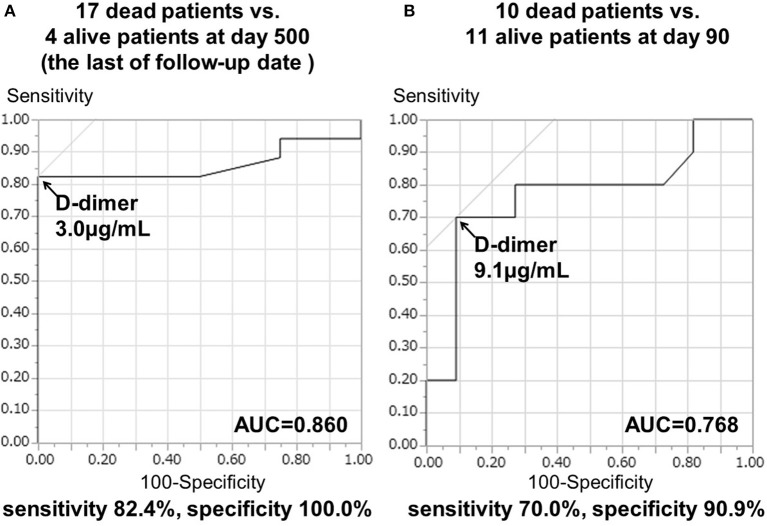
ROC curve analysis of D-dimer levels during days 7–28 and prognosis in TS patients. Repeated D-dimer measurements between days 7 and 28 were performed in 21 cancer patients. (A) AUC ± standard error (SE) to differentiate 17 deceased patients from four surviving patients at day 500. (B) AUC ± SE was used to differentiate 10 deceased patients from 11 surviving patients at day 90.